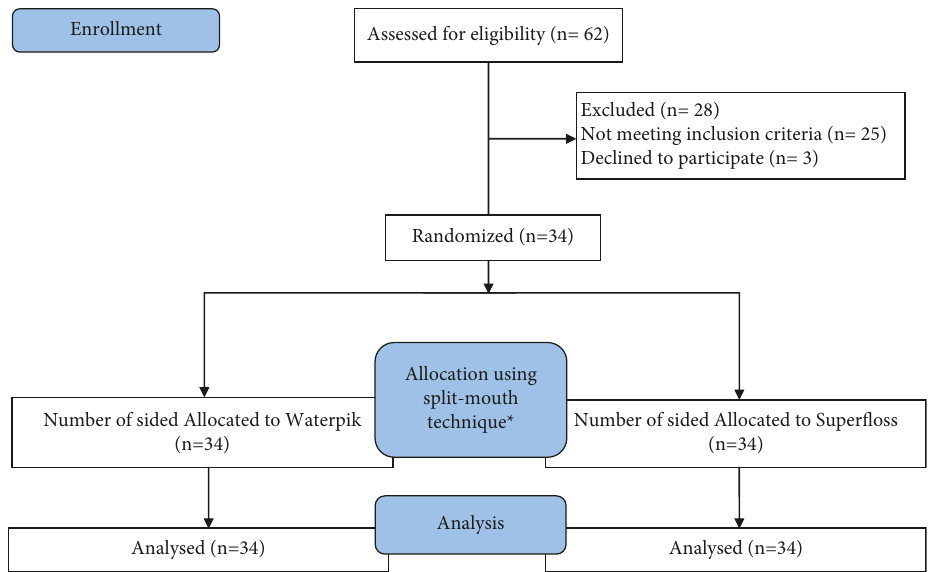
Figure 2: Consort diagram, participants’ flow chart and inclusion for per protocol analysis. Table 1: Comparison of plaque levels between super floss and water floss pre- and post-cleaning on selected teeth.